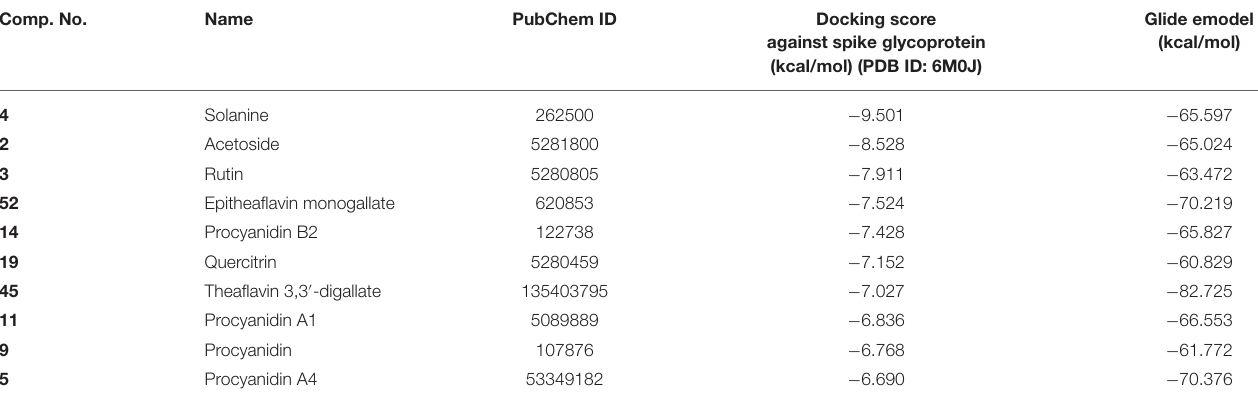
TABLE 2 | Chemical structures and docking results of phytoconstituents on spike receptor-binding domain of SARS CoV-2 bound to the ACE2. Comp.